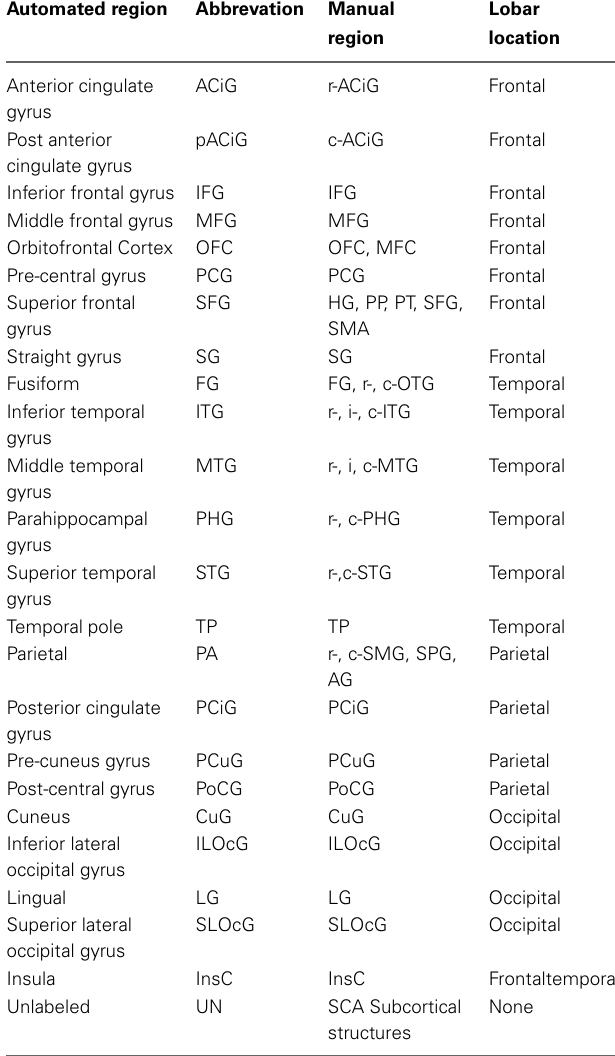
Table 4 | Cortical regions used in the automated